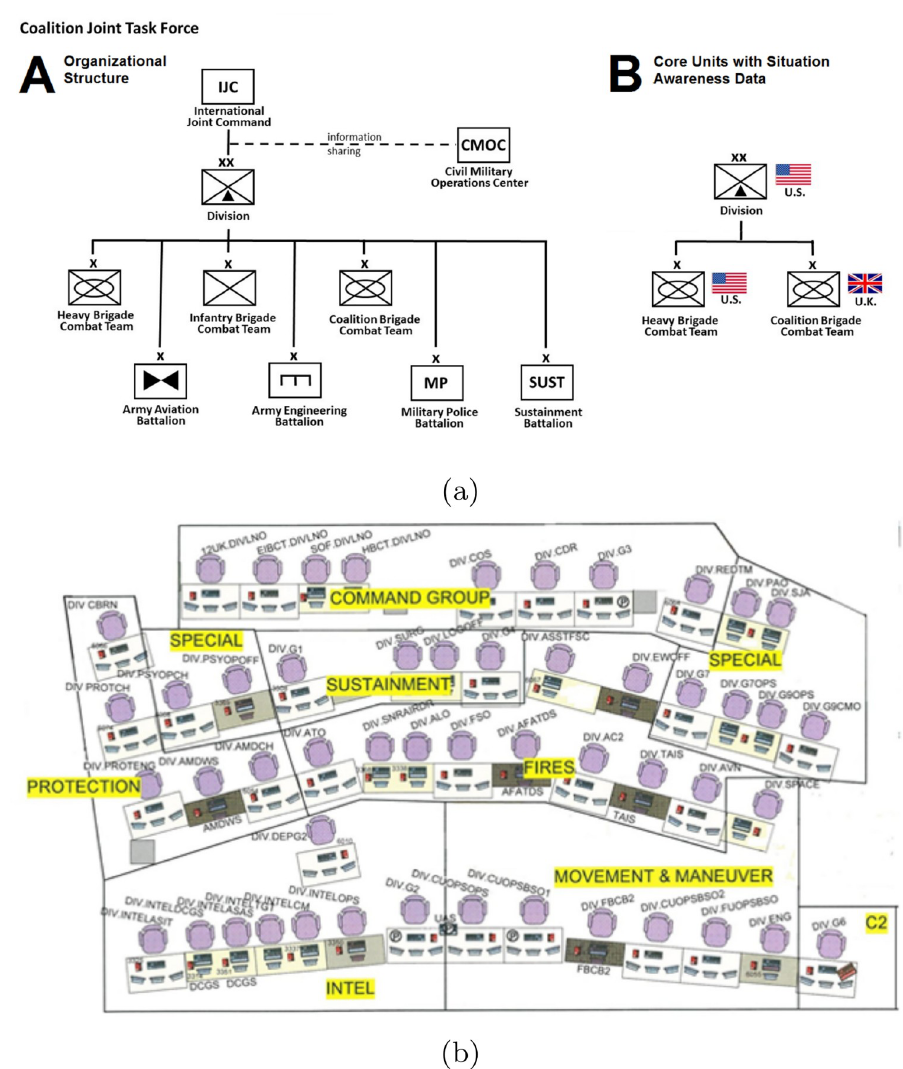
Fig 1. Coalition joint task force. (a) (left) Organizational structure of the Coalition Joint Task Force during the two- week military training exercise held at the Mission Command Battle Laboratory (Fort Leavenworth, Kansas). The network organization spans multiple echelons from Joint Command to Division to Brigade to support Battalions. (right) The core units exercised during the training event and subjected to our analysis- the Mission Command staff of a U.S. Division and two sub-ordinate Brigades, a U.S. Heavy Brigade Combat Team and a U.K. Coalition Brigade Combat Team. Individual situation awareness data was collected from the participating staff of these three core units. (b) Example seating chart for the Mission Command staff of the U.S.